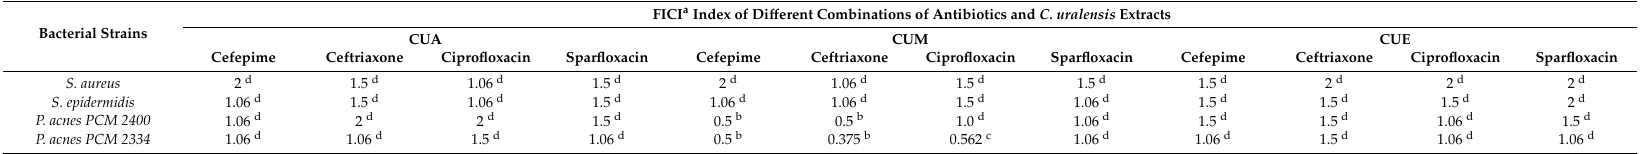
Table 6. Interactions between C. uralensis extracts and selected antibiotics against acne